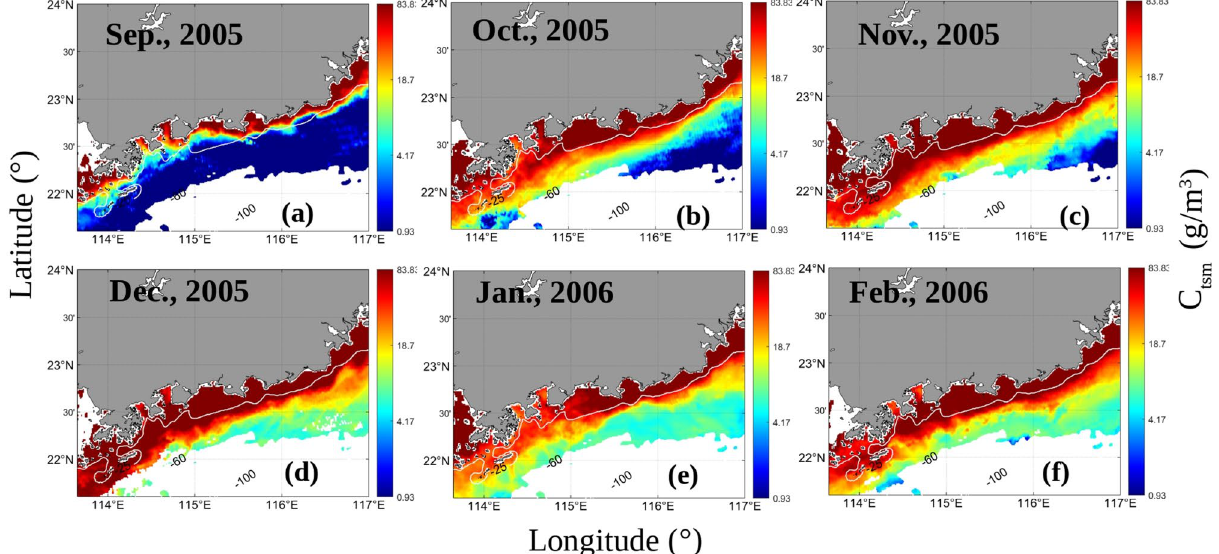
Figure 11. The monthly mean C tsm (g m −3 ) values from September 2005 to February 2006. The program R (version 3.6.3, available at https:// www.r- proje ct. org) was applied for the map.